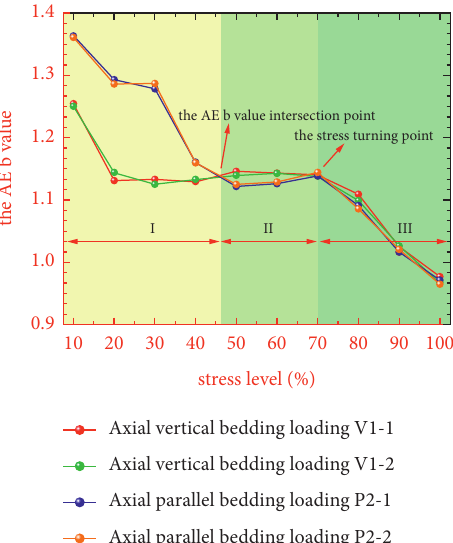
Figure 6: Variation curve of acoustic emission b value of raw coal sample with parallel bedding with stress level.